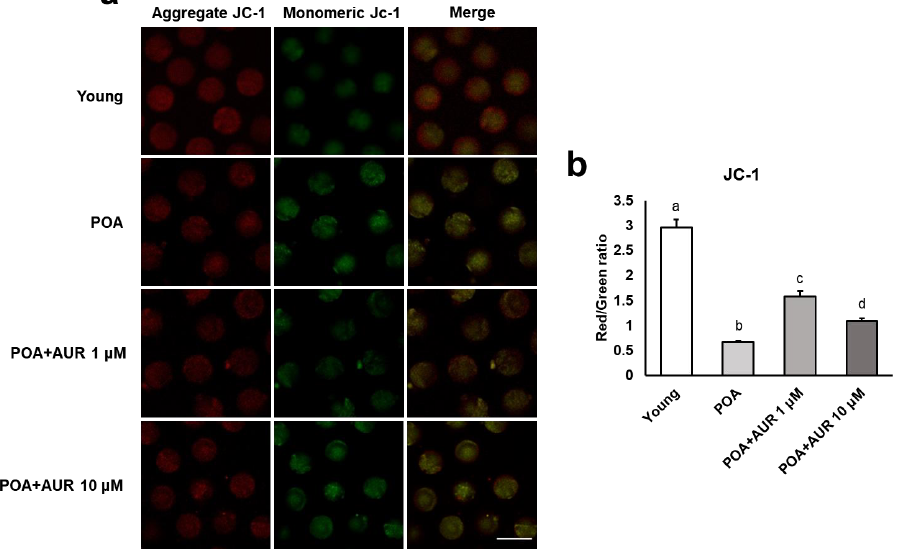
Figure 3. AUR enhanced mitochondrial function by raising ΔΨm during postovulatory aging. ( a ) Representative images of mitochondrial ∆Ψ m in young and aged oocytes with or without AUR administration. Oocytes were stained with the cationic dye JC-1, which can selectively enter mito- chondria and reversibly turn the emitted green fluorescence into red depending upon the mitochon- drial membrane potential (aggregated JC-1: high potential marker, red; monomeric JC-1: low poten- tial marker, green); scale bar = 20 μm. ( b ) The ratio of red to green fluorescence intensity in each group of oocytes. Data are presented as the means ± SEMs of at least three independent experiments. Significant difference indicated by lowercase letters of the alphabet, p < 0.001.